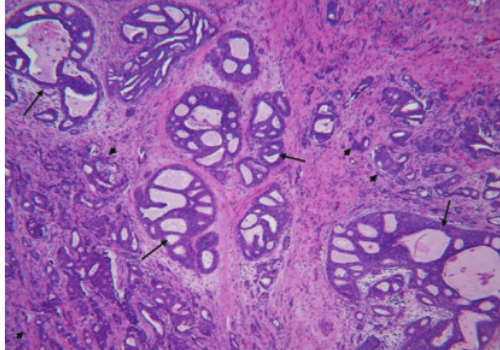
Figure 2: Representative histology of all four cases. There is exten- sive DCIS with cribriform configuration (arrow). The multiple foci of invasion (arrowhead) occur in between the DCIS (magnification ×